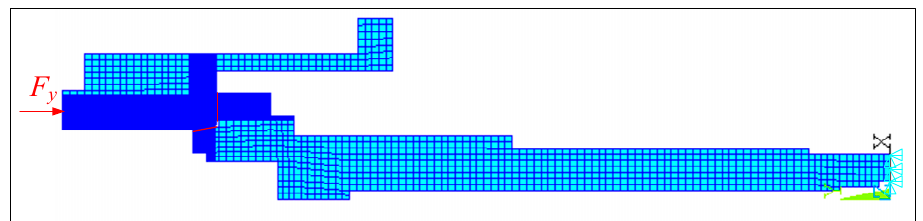
Figure 7. Spindle–GWF mesh and boundary conditions.